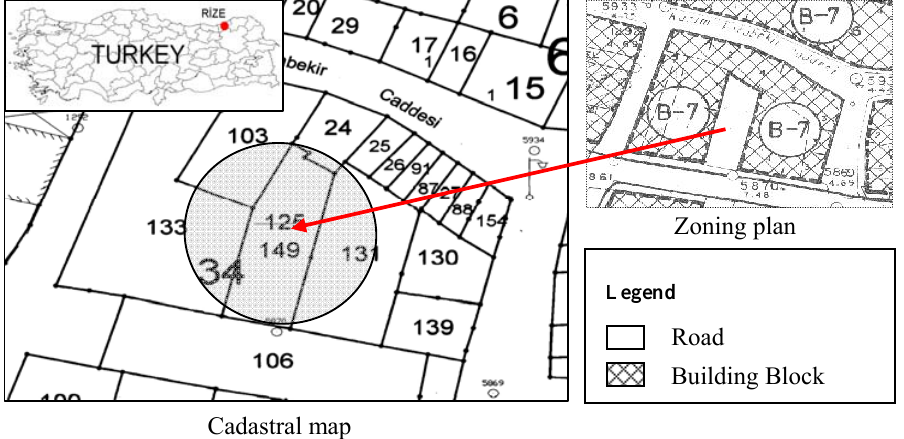
Figure 3 . A shop built under parcel 149 in Çar ş ı district with zoning